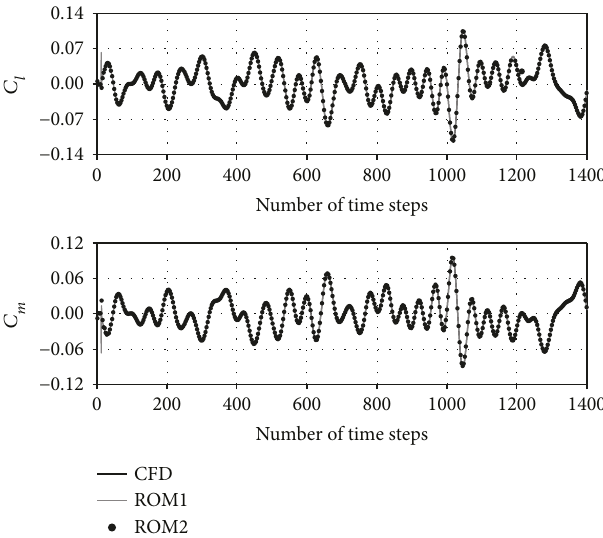
Figure 10: The ROM validation under the FWGN excitation at α M = 3 deg (ROM1-training data via CFD; ROM2- ∞ = 0 76 and 0 training data via the proposed method).